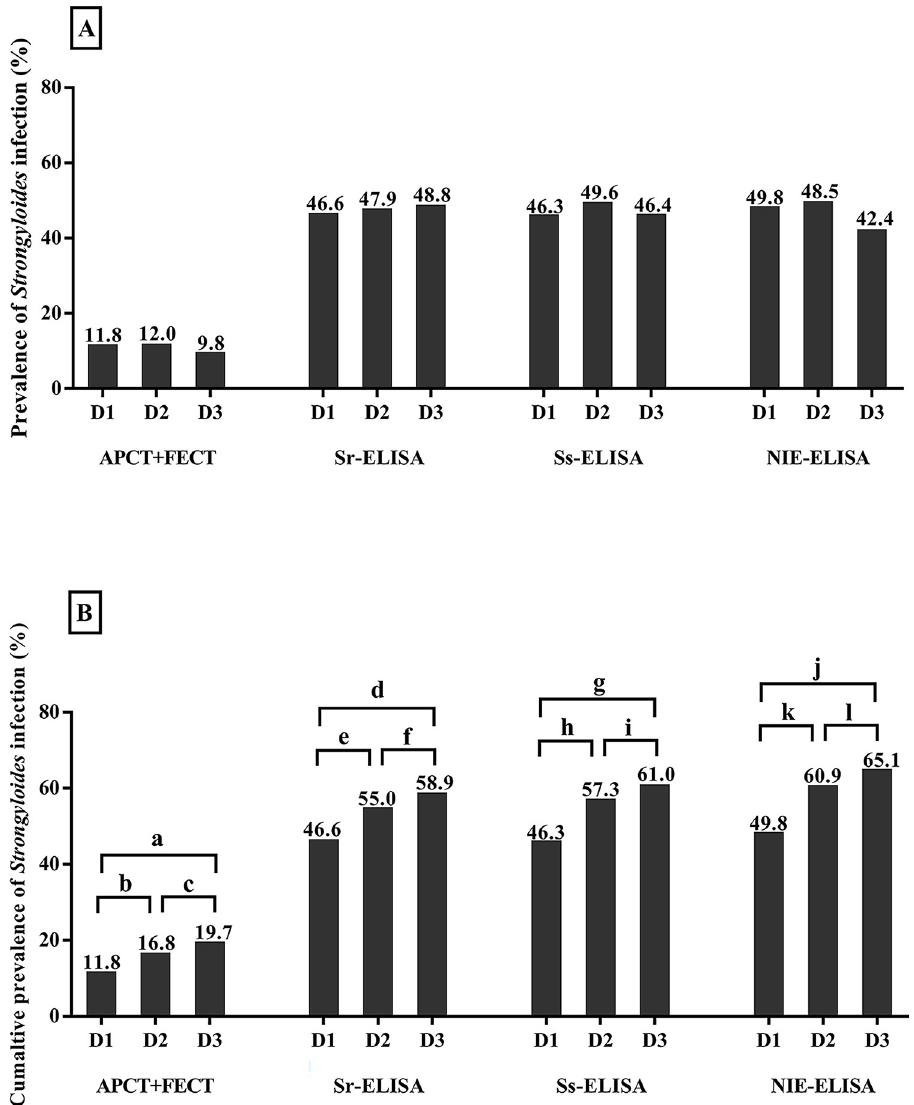
Fig 1. Daily and cumulative prevalence rates of Strongyloides infection according to fecal examination and urine ELISA methods (n = 966). Panel A shows the prevalence rates for each of three successive days (D1: day1, D2: day2, D3: day3). Panel B shows the cumulative prevalence rate for three days (D1: day1, D2: day 1 and 2, D3: day 1, 2 to day 3). The small letter symbols (a-l) represent the McNemar’s chi-square value for a statistical comparison between pairs of prevalence estimates with p value < 0.0001; a = 66, b = 44, c = 28, d = 106, e = 38, f = 77, g = 130, h = 101, i = 35, j = 151, k = 109, and l = 47.